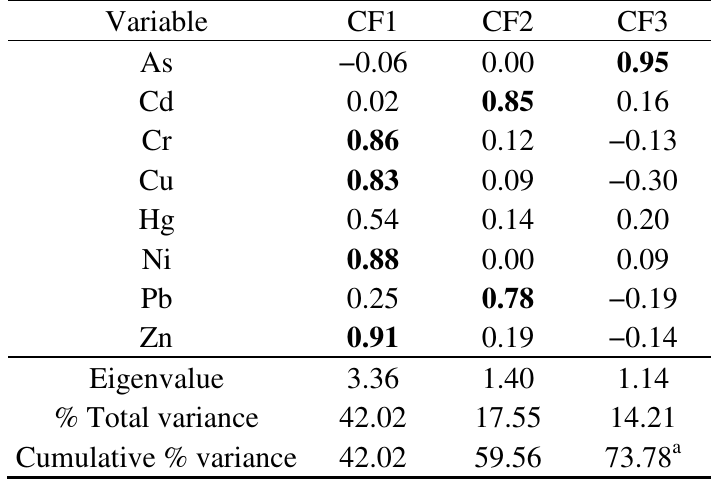
Table 2. Results from the factor analysis for heavy metals in